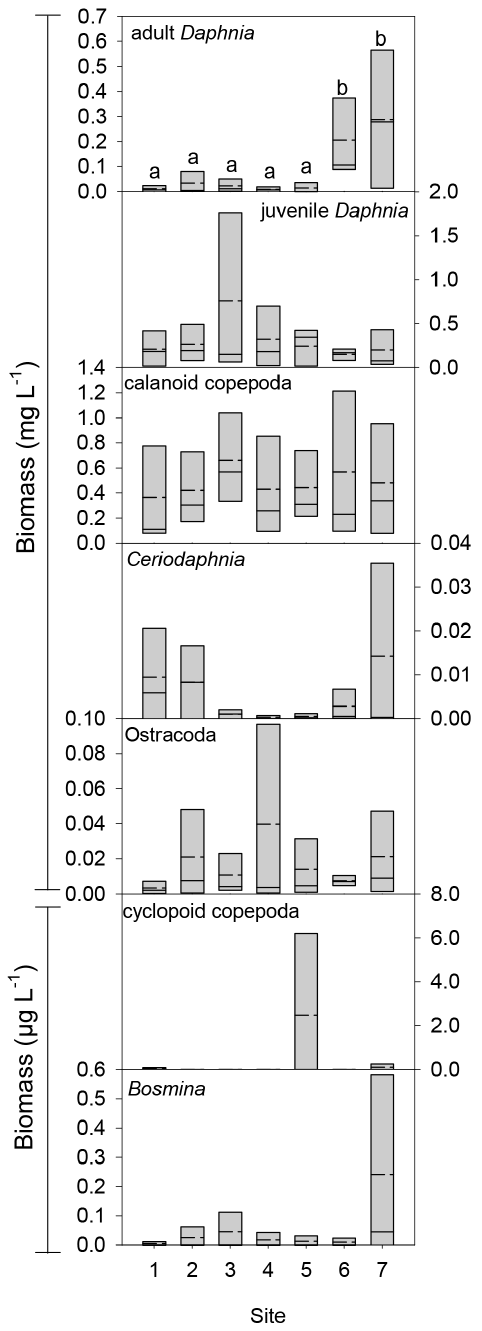
Figure 3. Boxplots for mean biomass of each zooplankton group at each site. Boxes are the 25 th and 75 th percentile, solid lines are median and dashed lines are means (N=5). Boxplots that do not share a common letter are significantly different.